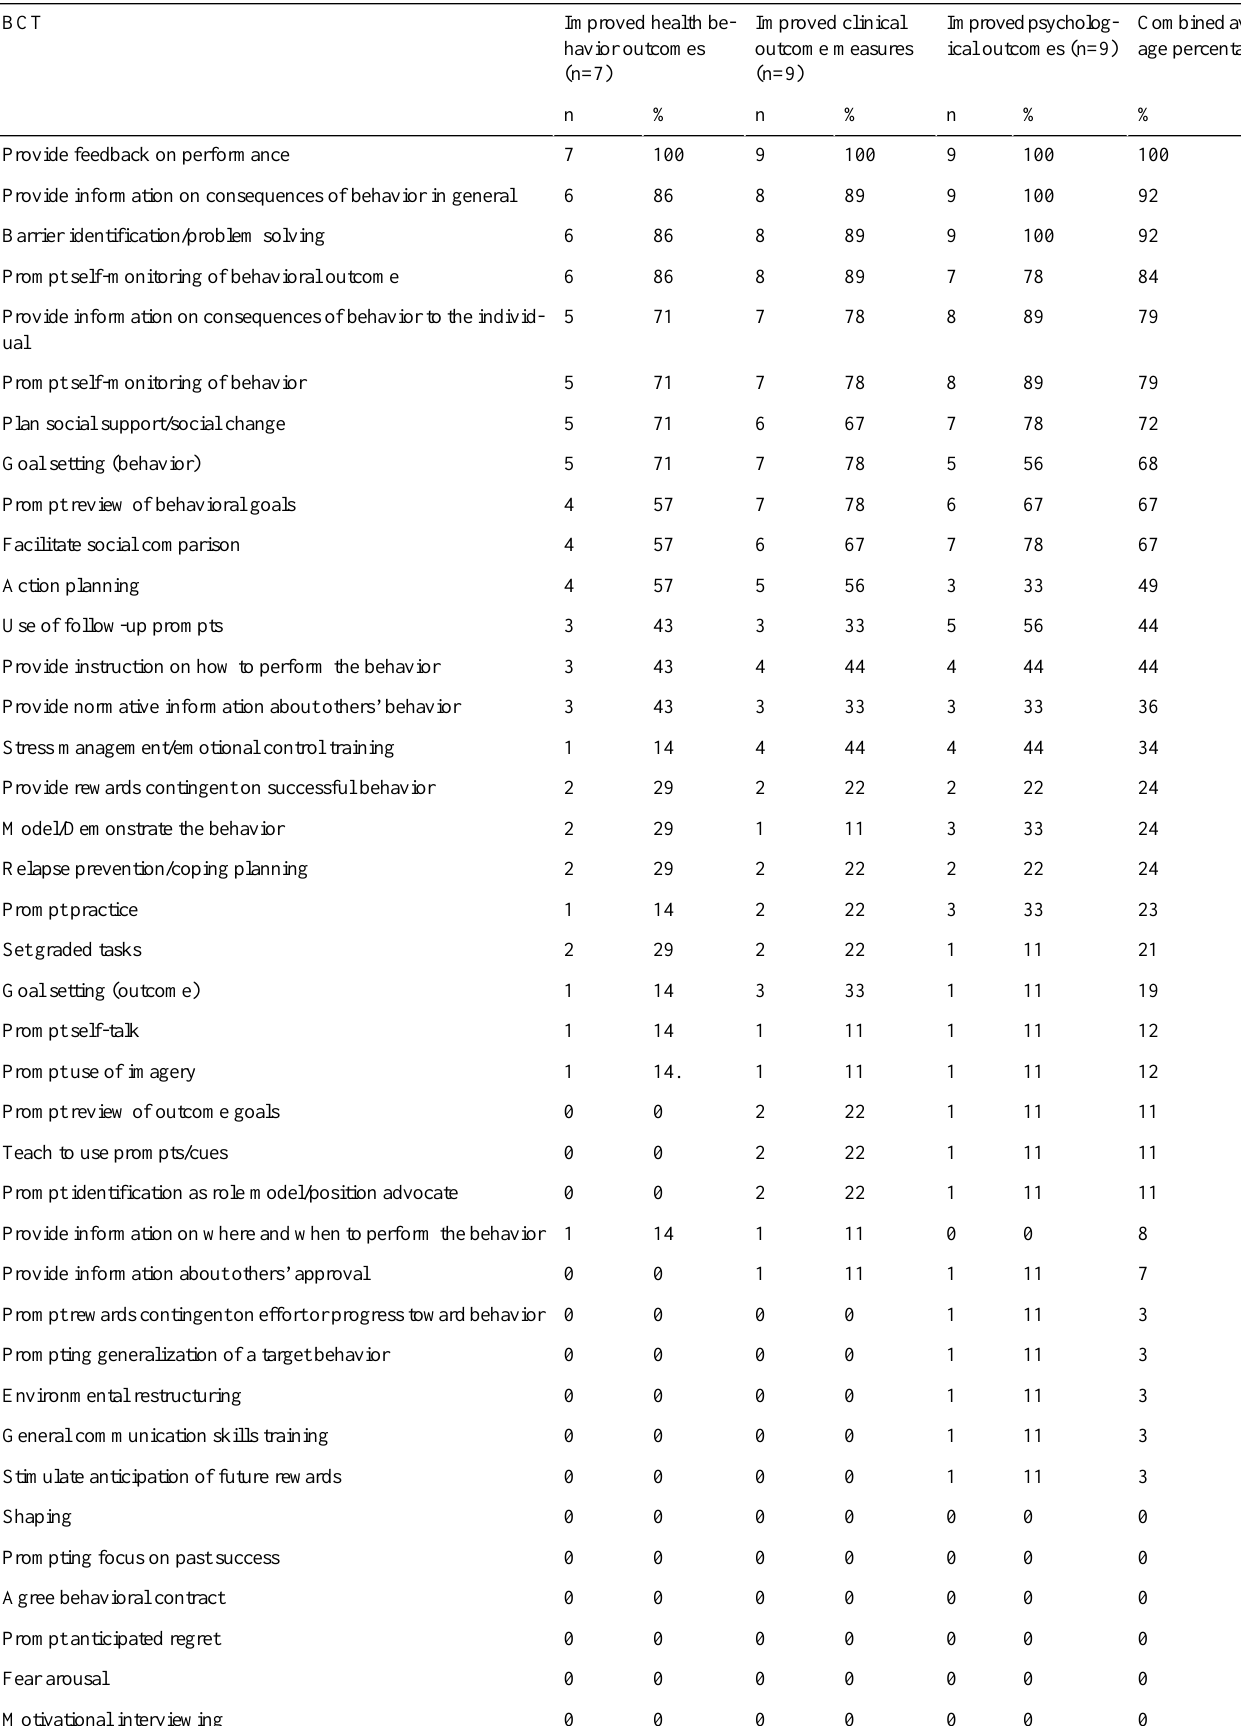
Table 6. Frequency of behavioral change techniques (BCTs) per improved study outcome.